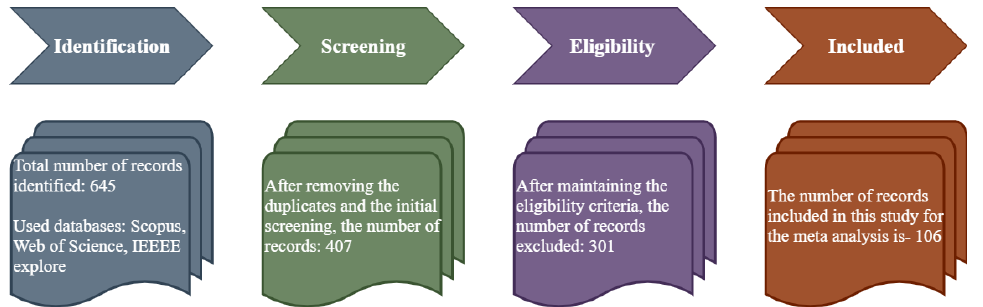
Figure 1. Block diagram of the article selection